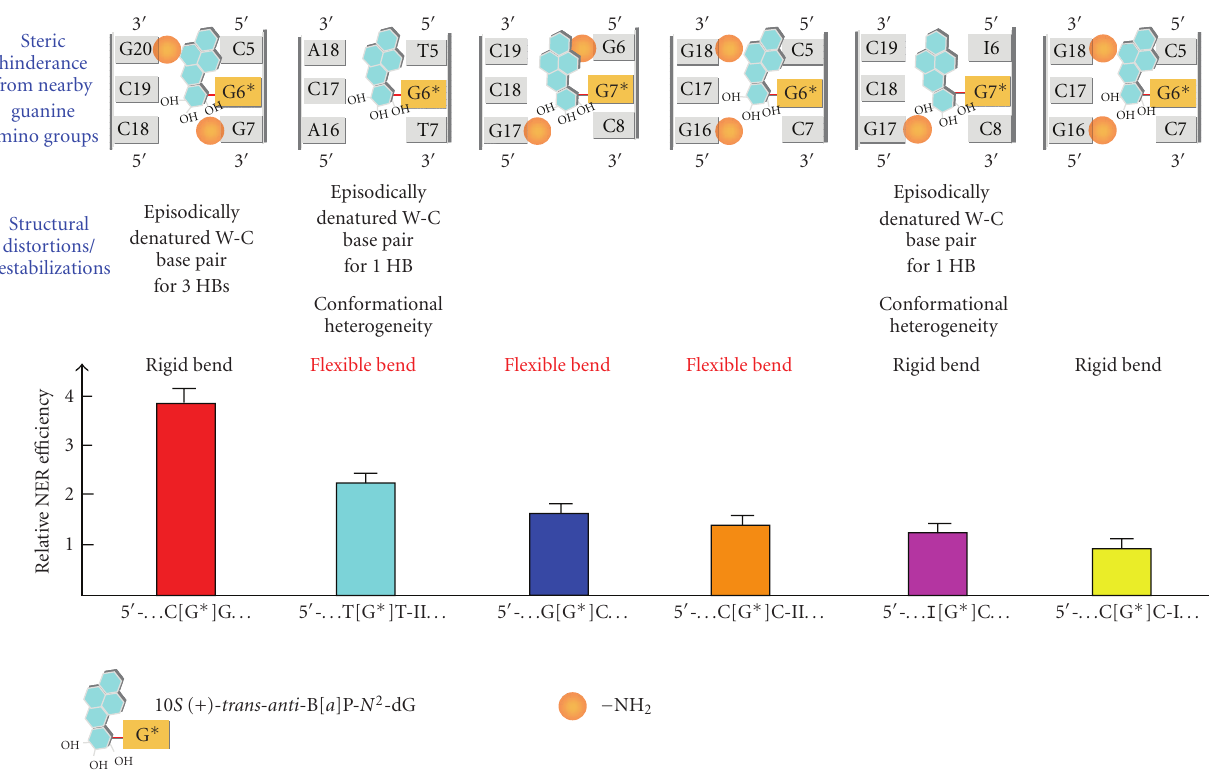
highly flexible bend [59, 60]. Also, the 5 (cid:3) - ... T[G ∗ ]T-II ...